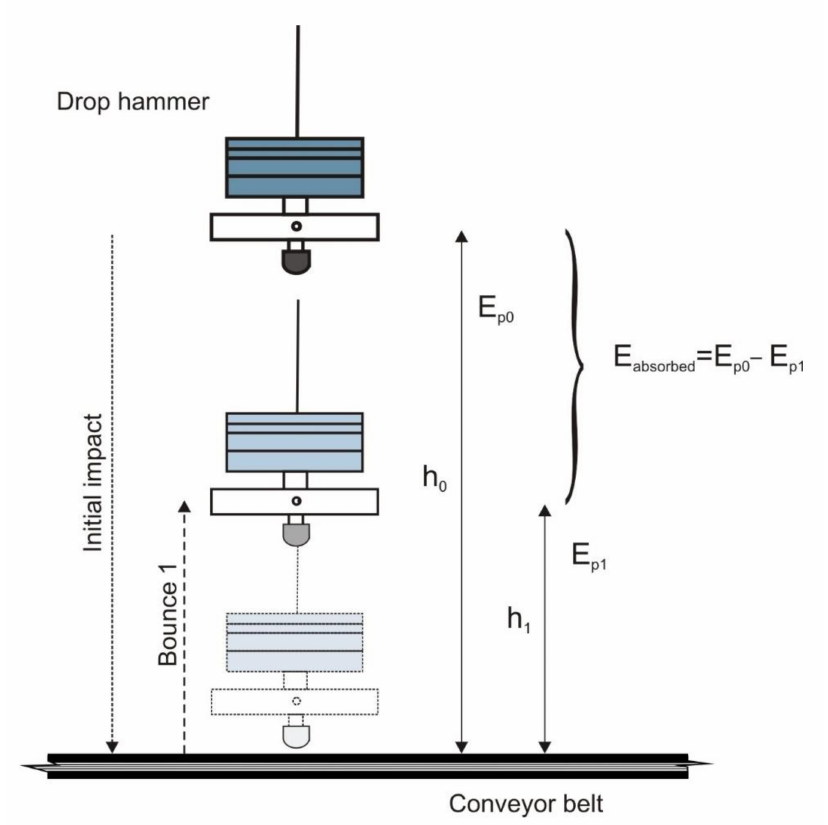
Figure 2. Impact and Bounce 1 of the drop